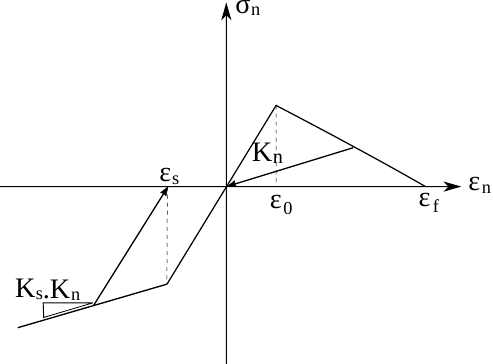
Figure 1. Contact behavior between two particles subjected to tension in normal